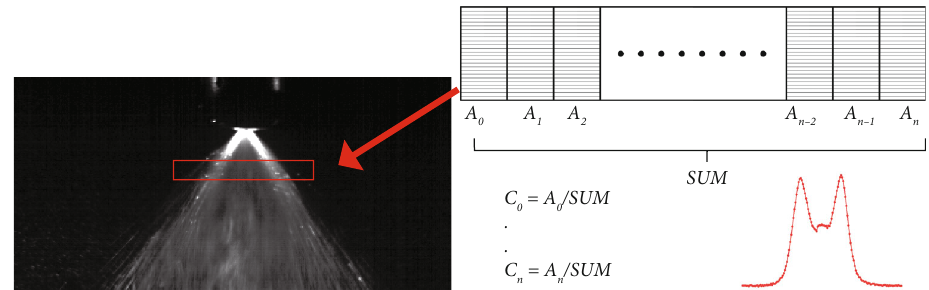
Figure 3: Postprocessing for volume concentration information.